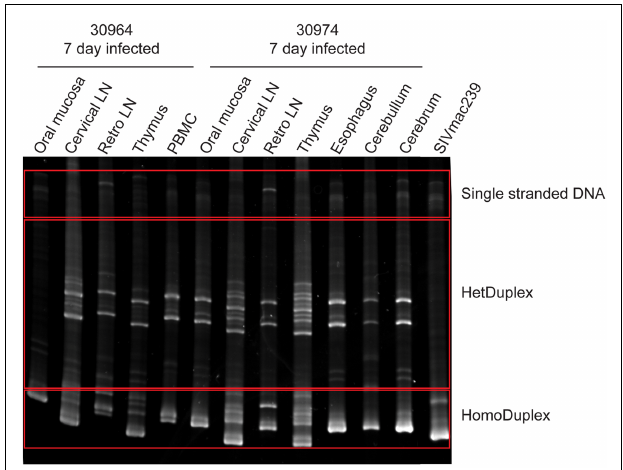
FIGURE 2 | Heteroduplex mobility assay of viral DNA from lymphoid, mucosal, and brain tissues .The PCR amplified SIV envelope gene spanning theV1–V2 region was heated and rapidly re-annealed prior to separation by electrophoresis through a non-denaturing polyacrylamide gel and visualized by ethidium bromide staining.Two heteroduplex bands predominated in the majority of tissues examined indicating a limited viral